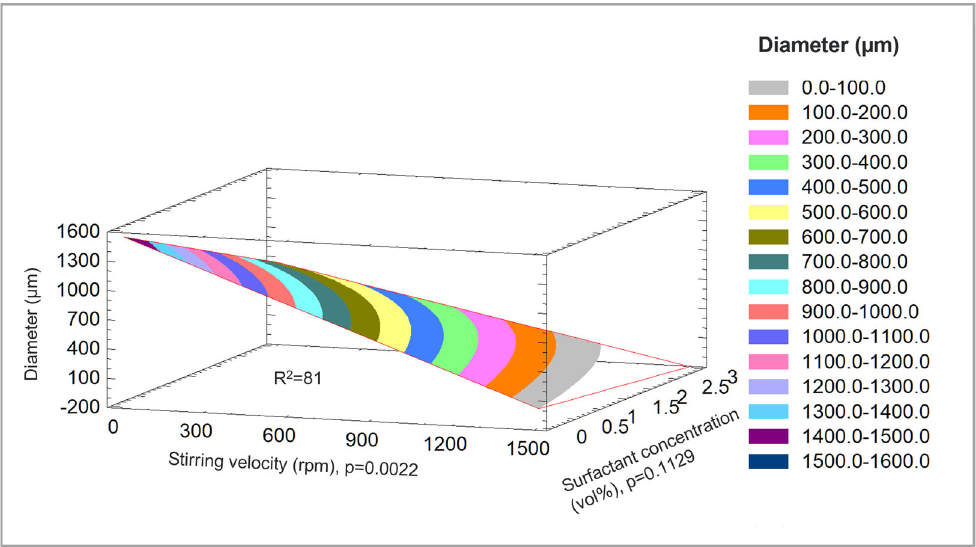
Figure 4. Full two ‐ level factorial design of the DGL/PEG hydrogel microspheres preparation. Esti ‐ Figure 4. Full two-level factorial design of the DGL/PEG hydrogel microspheres preparation. Aver- mated response surfaces of average microspheres diameter obtained in function of the stirring speed age microsphere diameters obtained in function of the stirring speed during water in oil emulsion, during water in oil emulsion, and surfactant concentration. and surfactant